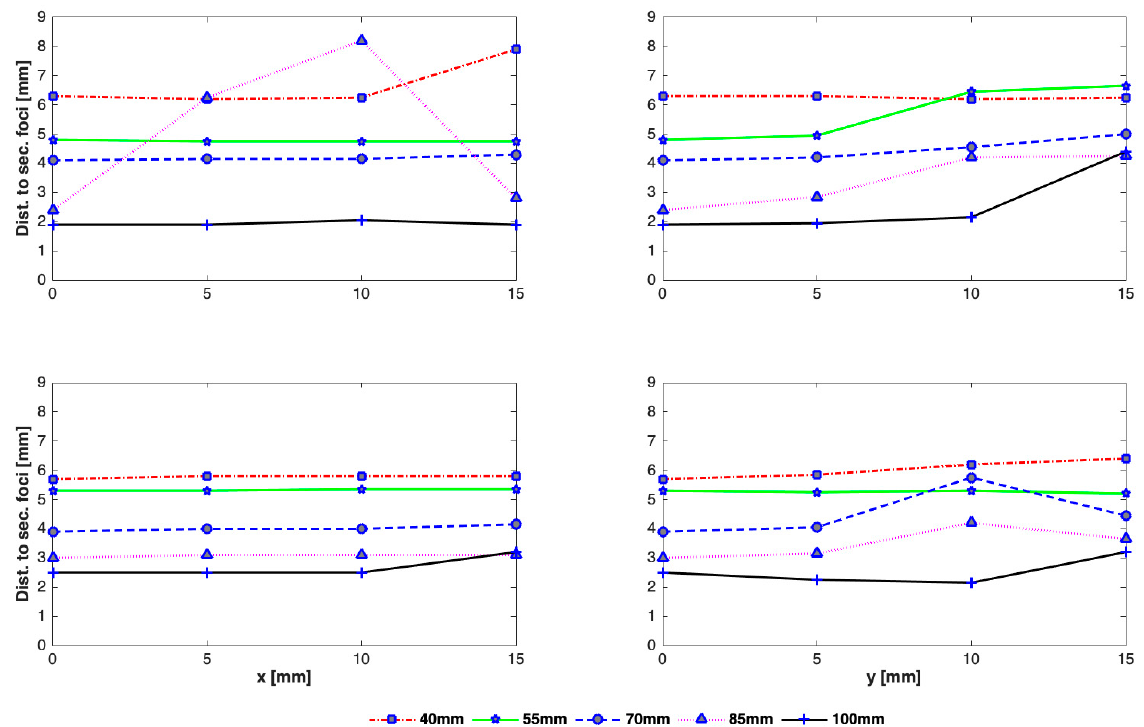
Figure 11. Effect on the distance to secondary foci from main focus with transverse steering for rib cage positioned at 40 mm, 55 mm, 70 mm, 85 mm, 100 mm and when the array axis crosses center of the rib ( top row ), intercostal space ( bottom row ), steered in x-direction ( left column ), y-direction ( right column ).